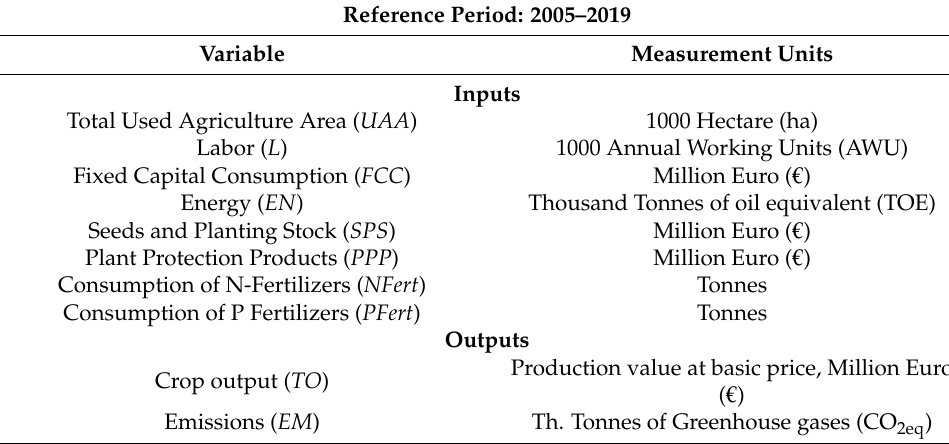
Table 2. Data selection Inputs and Outputs for reference period